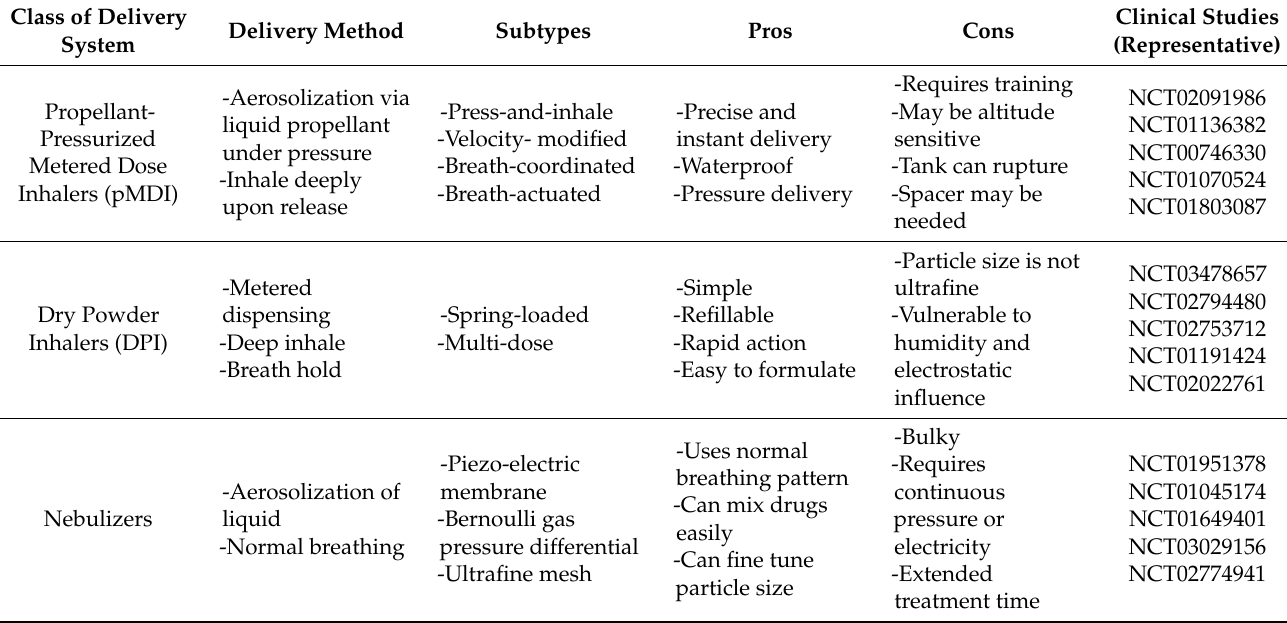
Table 2. Summary of Asthma Treatment Delivery